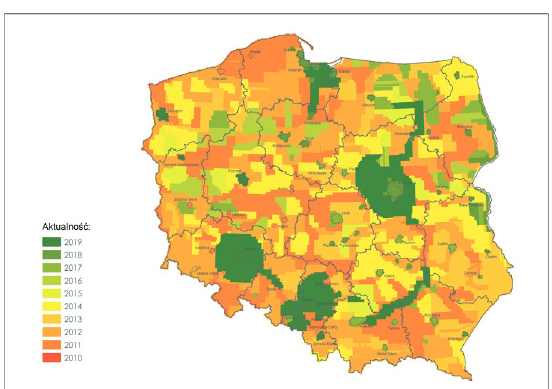
Figure 6 Actual state LIDAR data in national resource 3. PHOTOGRAMMETRIC DATA AS A PART OF NATIONAL SPATIAL DATA INFRASTRUCTURE